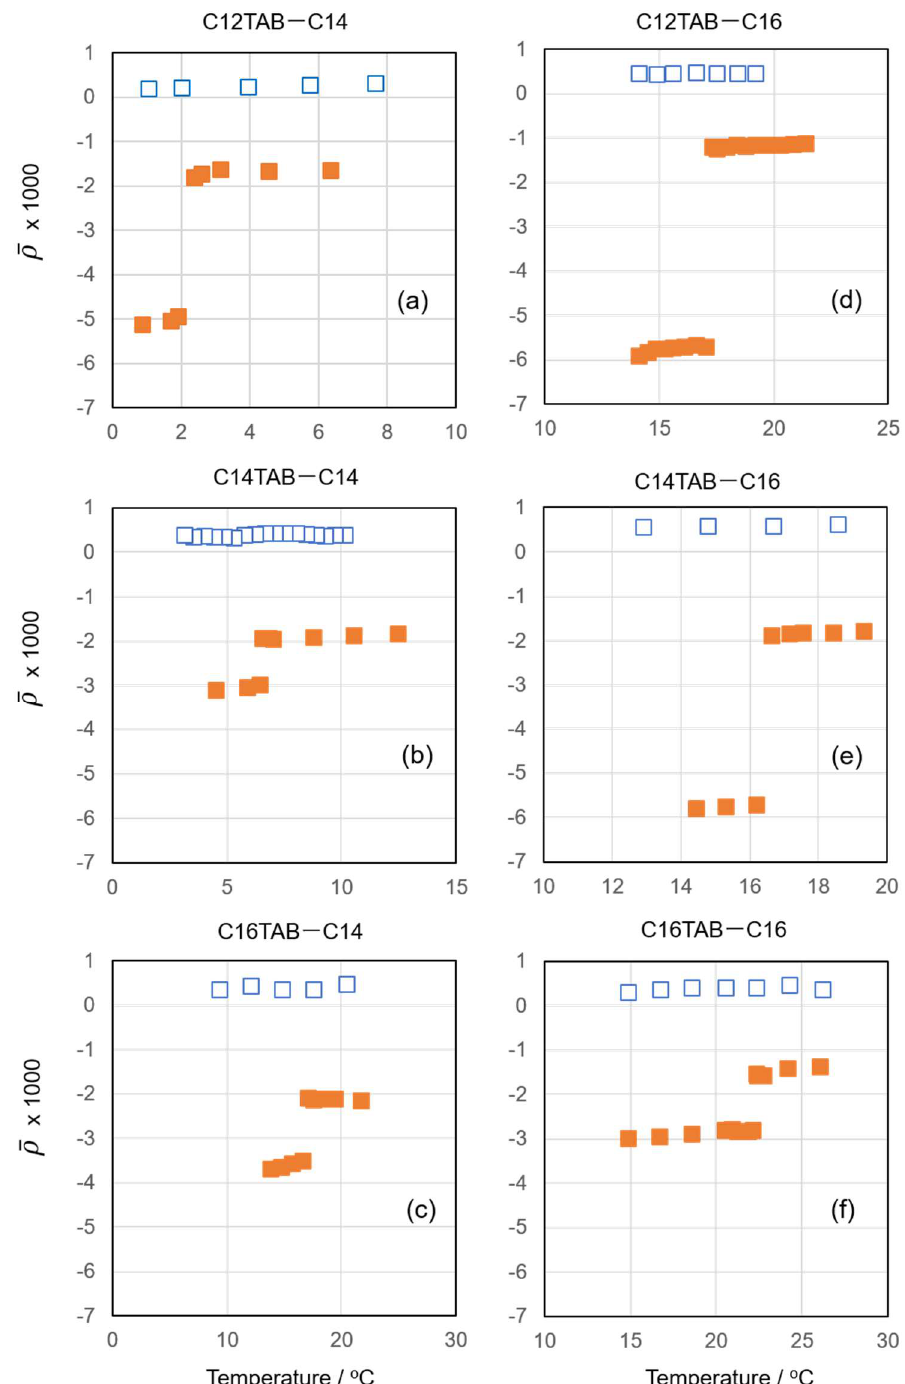
Figure 1. Coefficient of ellipticity vs. temperature plots for ( a ) C12TAB + C14 at surfactant concentra- tions m = 0.20 (blue open squares) and 4.00 (orange filled squares) mmol kg − 1 , ( b ) C14TAB + C14 at surfactant concentrations m = 0.05 ( (cid:3) ) and 1.50 ( (cid:4) ) mmol kg − 1 , ( c ) C16TAB + C14 at m = 0.02 ( (cid:3) ) and 0.41 ( (cid:4) ) mmol kg − 1 , ( d ) C12TAB + C16 at m = 0.20 ( (cid:3) ) and 4.00 ( (cid:4) ) mmol kg − 1 , ( e ) C14TAB + C16 at m = 0.05 ( (cid:3) ) and 3.50 ( (cid:4) ) mmol kg − 1 , and ( f ) C16TAB + C16 at m = 0.02 ( (cid:3) ) and 0.40 ( (cid:4) ) mmol kg − 1